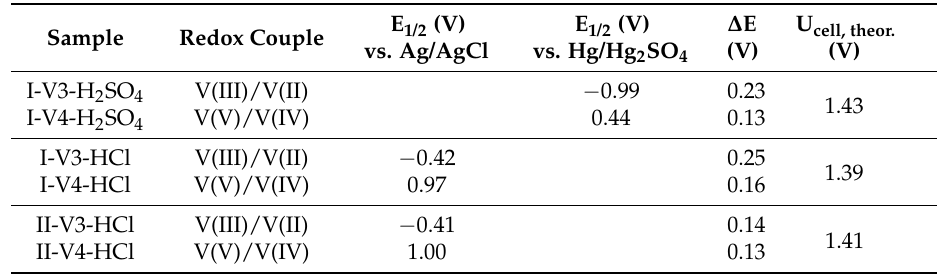
Table 3. Electrochemical characteristics of redox couples of anolyte and catholyte: half-wave potential (E 1/2 ) and peak-to peak separation ( ∆